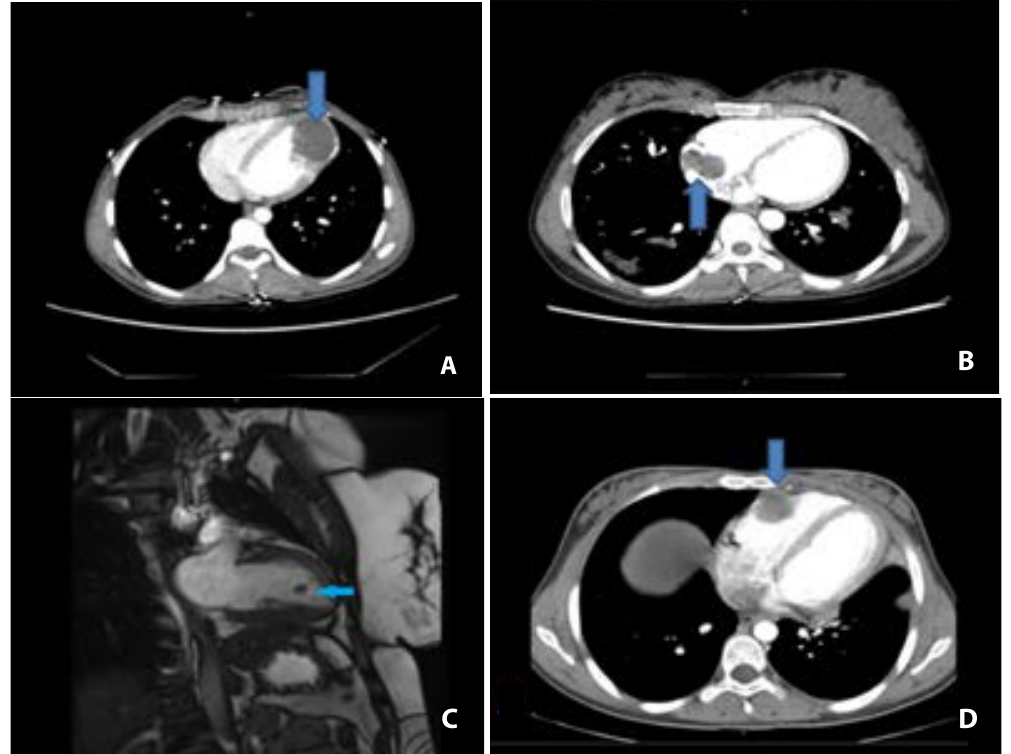
Fig. 1 – CT and MRI images of cardiac hydatid